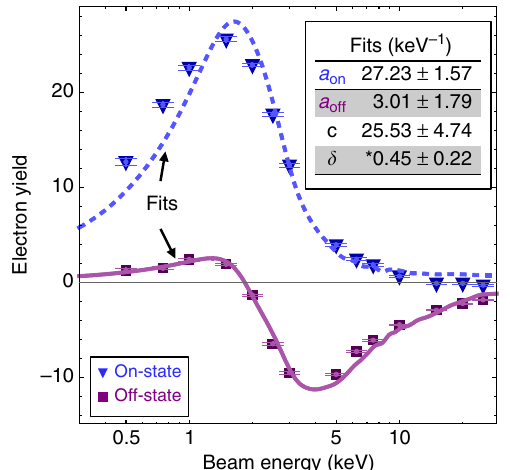
Fig. 7 Experimental fi t of beam energy dependence. Measured electron yield as a function of energy. Error bars indicate two standard deviations of the mean within an 11 × 11 pixel box at the signal center for the on-state and off-state micrograph series in Fig. 5. All quantities are measured with respect to the background. Fits are shown with least-squares 95% con fi dence intervals with units of keV − 1 (*note δ is dimensionless). Only the least-squares coef fi cient for the internal secondary electron emission (ISEE) signal, a , with associated variables a on and a off changes between the off state and the on